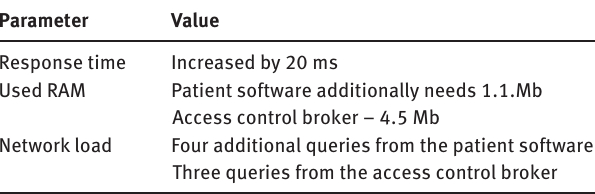
Table 2: The Main Parameters of the Access Control Module